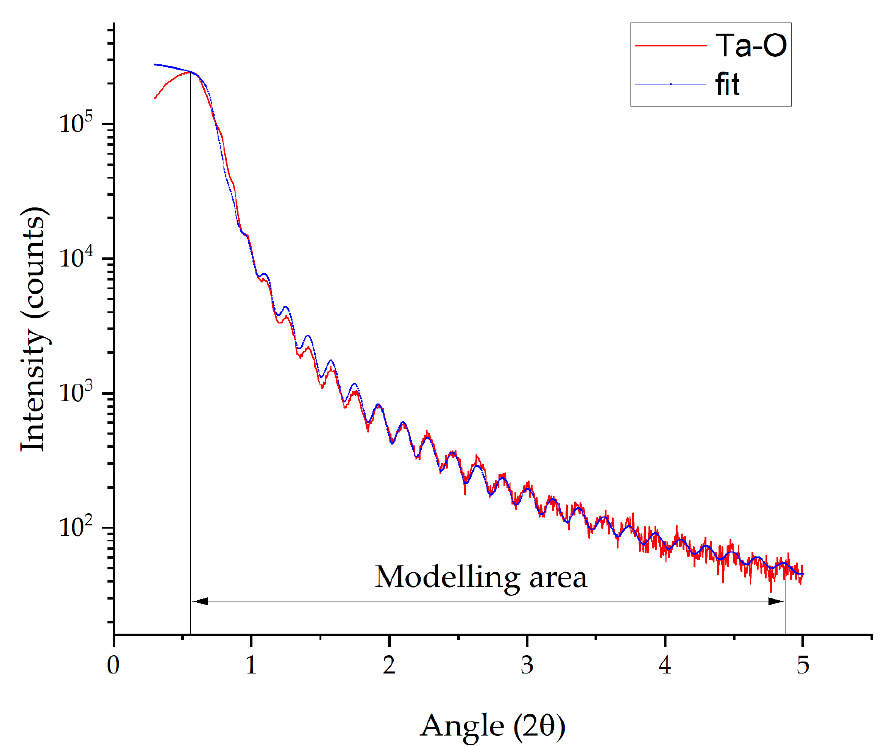
Figure 7. SEM of the surface ( a ) and cleavage ( b ) of the Ta-O_6 sample on a steel substrate.